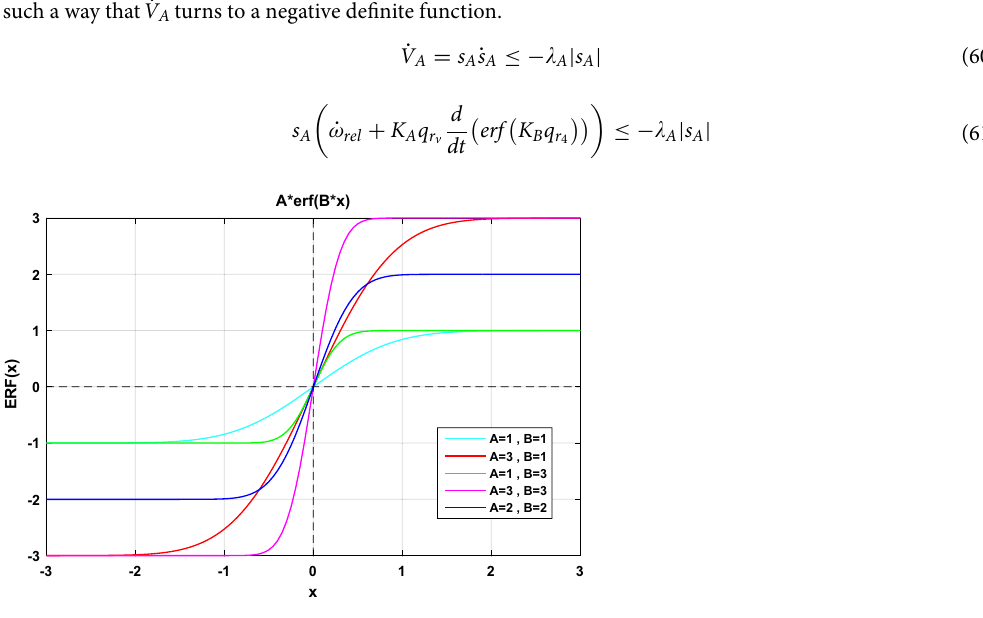
Figure 10. Plot of the error